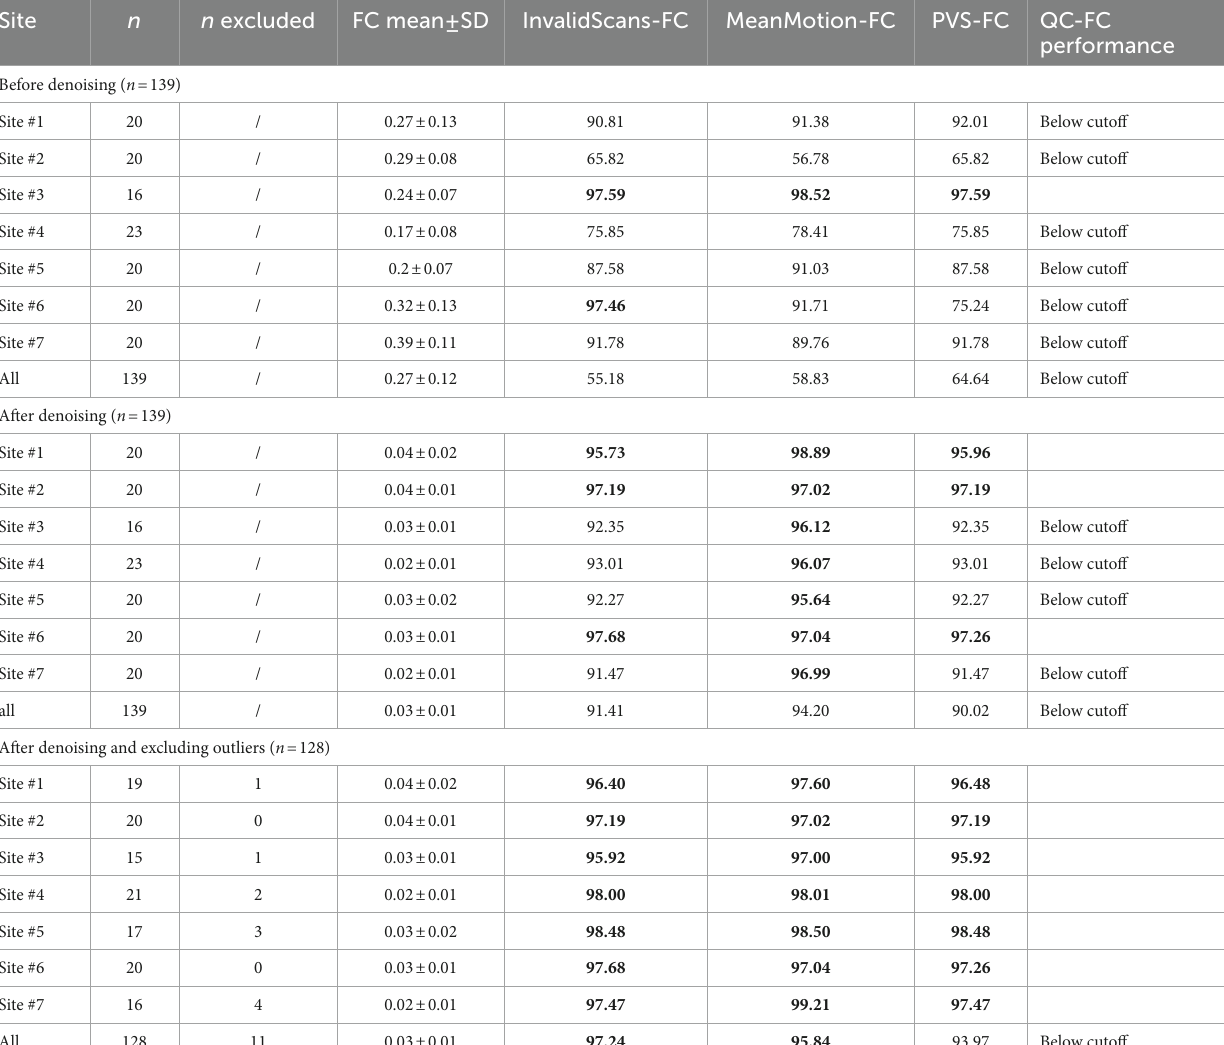
TABLE 3 FC density distributions and QC-FC